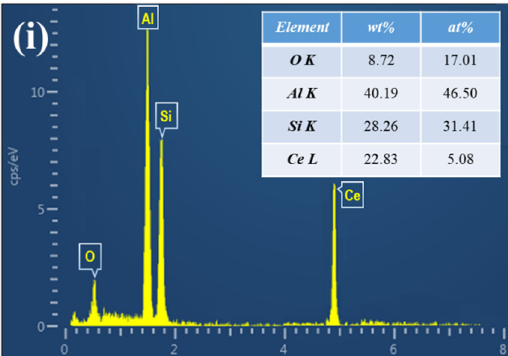
Figure 2. The SEM and EDS pictures of SiCp/Al-Si Composites with different CeO 2 Contents: ( a ) 0; ( b ) 0.15 wt%; ( c ) 0.30 wt%; ( d ) 0.60 wt%; ( e ) 1.20 wt%; ( f ) 1.80 wt%; ( g ) the energy spectrum diagram of region A in Figure 2f; ( h ) the energy spectrum diagram of region B in Figure 2f; ( i ) the energy spectrum diagram of region C in Figure 2f.